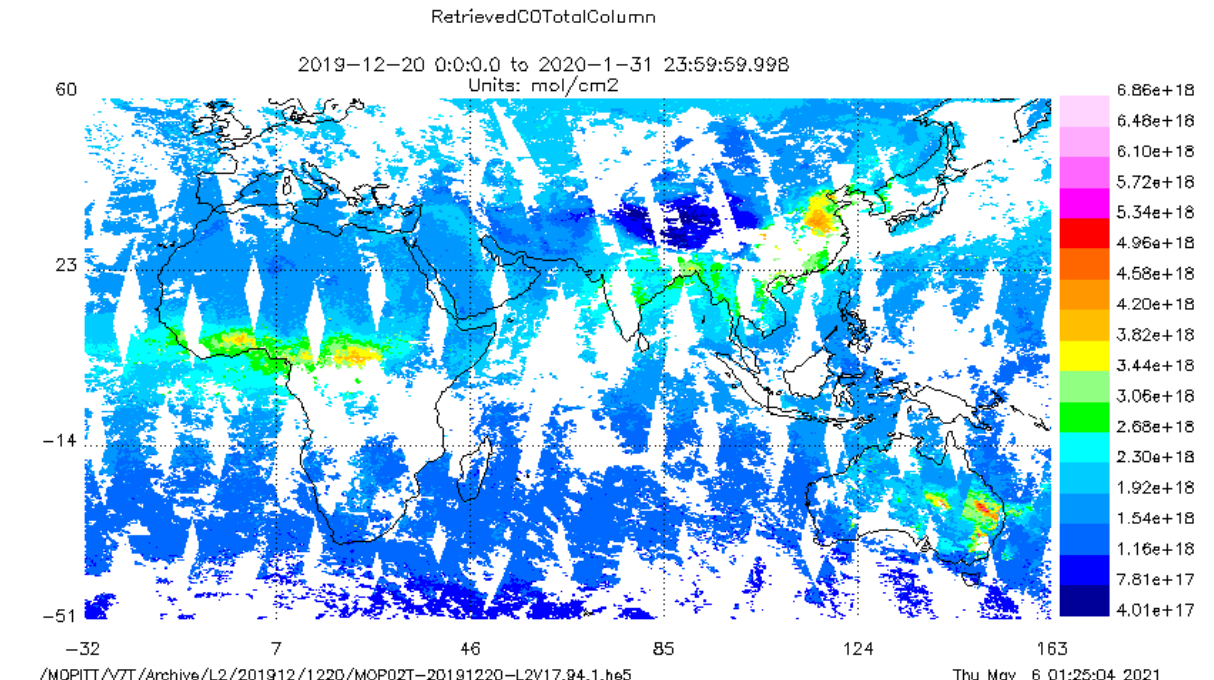
Figure 1. MOPITT total column CO (version 7) data product from 20 December 2019 to 31 January 2020, (generated in: https://www.acom.ucar.edu/mopitt/webview/plot-options.shtml, accessed on 6 May